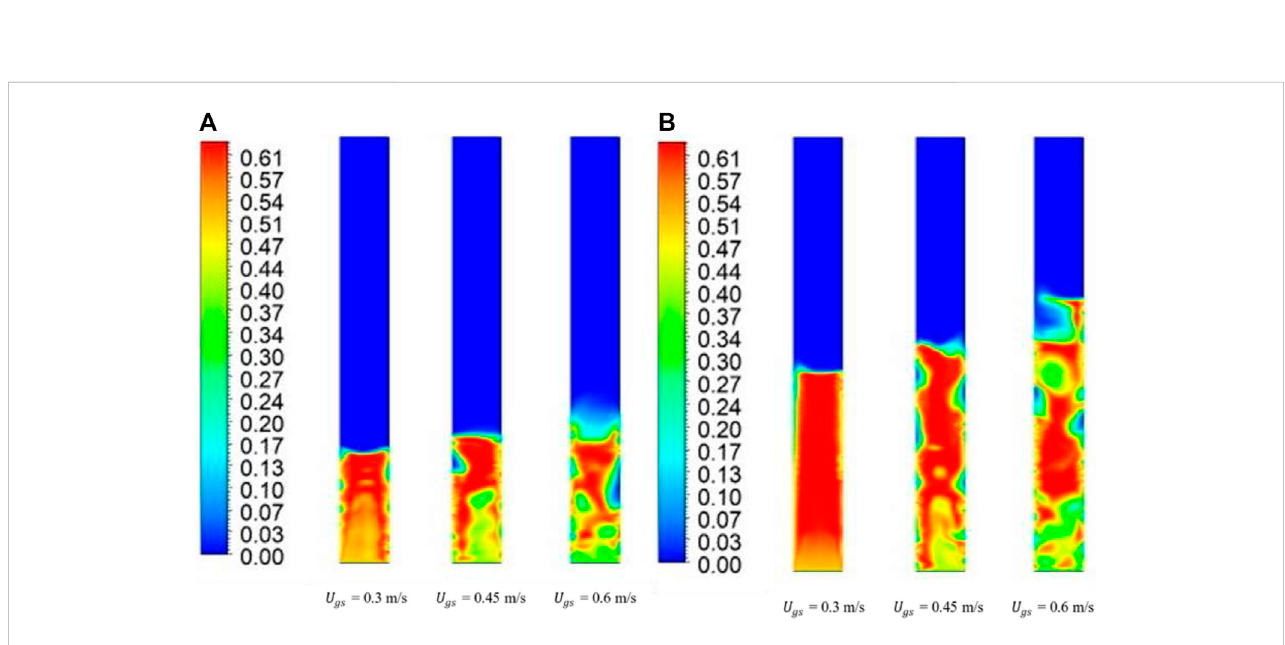
FIGURE 9 Time-averaged steady-state solid-phase volume fraction contours for 60% mixture at (A) 0.335 m bed height and (B) 0.635 m bed